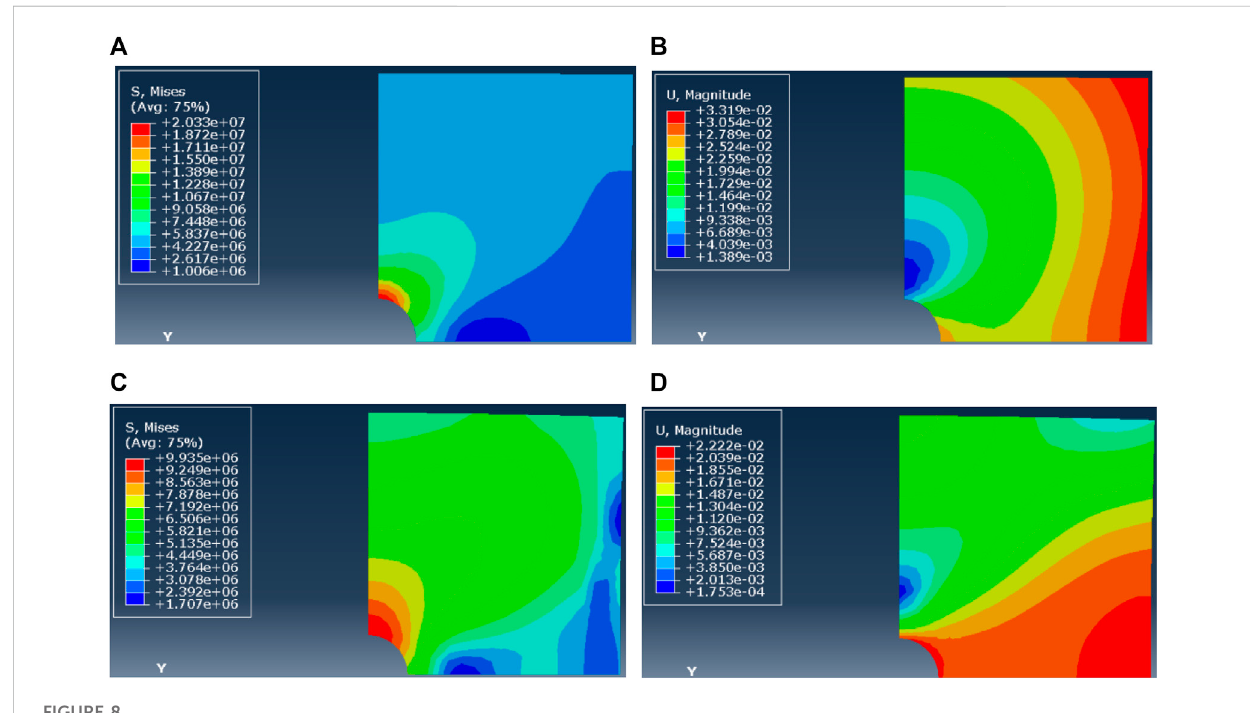
FIGURE 8 (A – D) Misesanddisplacementofboreholeshrinkage afterreaming( Δ P=5 MPa,n=1).Misesanddisplacementofboreholeshrinkageafterreaming ( Δ P = 5 MPa, n = 5)